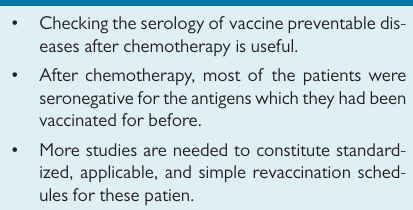
Figure 1. Assessment of patients and revaccination